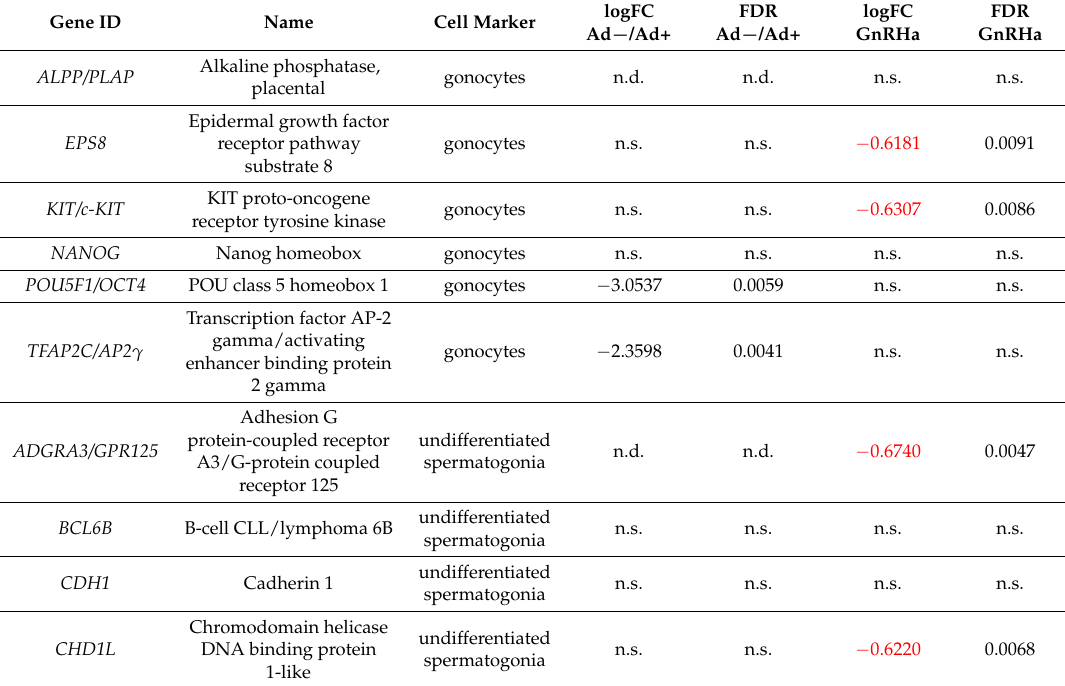
Table 1. Differential expression of gonocyte and spermatogonial marker genes involved in self-renewal and differentiation of spermatogonial stem cells (SSCs). Absolute fold changes (logFC) and false discovery rates (FDR) of differentially expressed genes in the Ad − vs. Ad+ group, and in the GnRHa (Buserelin, INN) treated vs. untreated group are indicated. Absolute fold changes <2 are highlighted in red; n.d.: not determined, n.s.: not